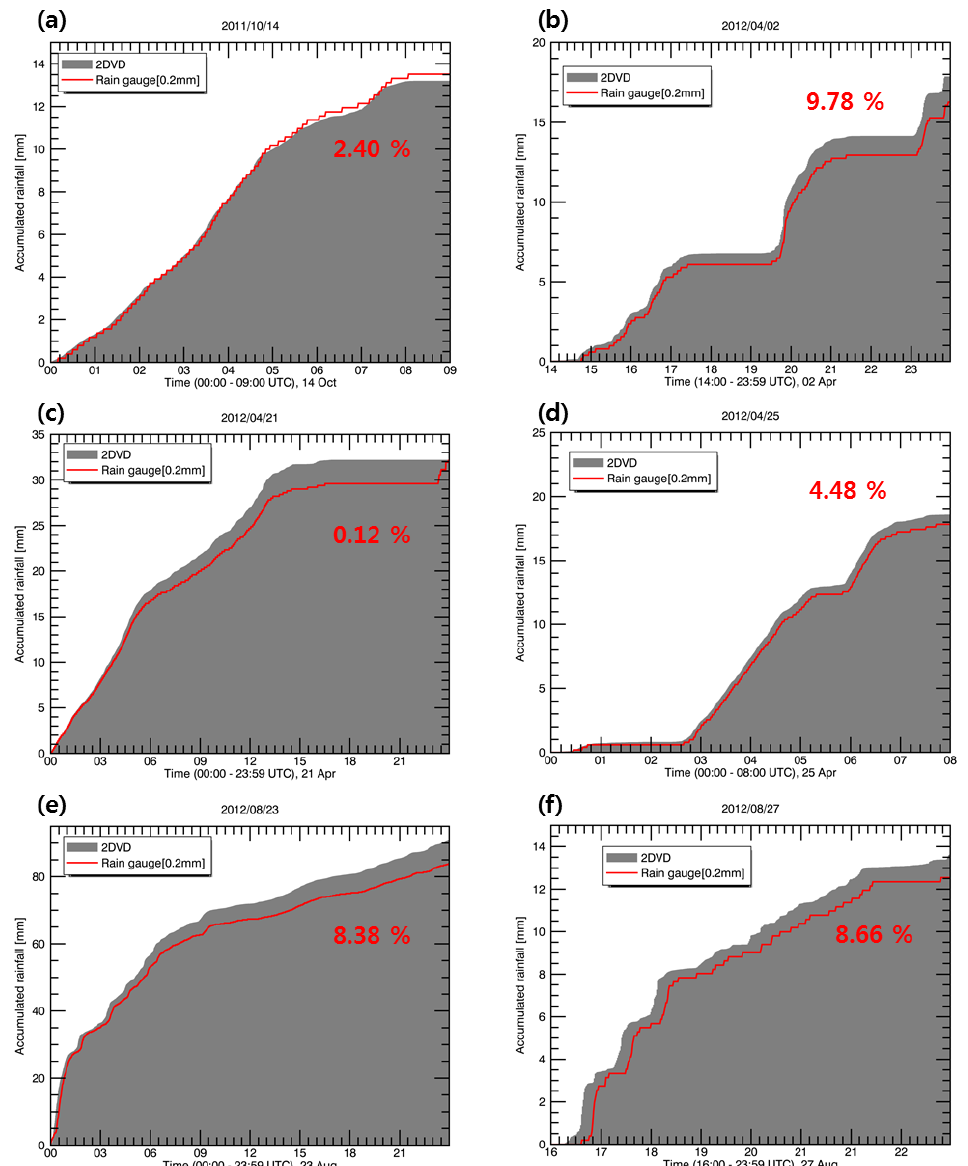
Figure 3. Time series of accumulated rainfall measured from the rain gauge and estimated from the 2DVD: (a) 14 October 2011, (b) 2